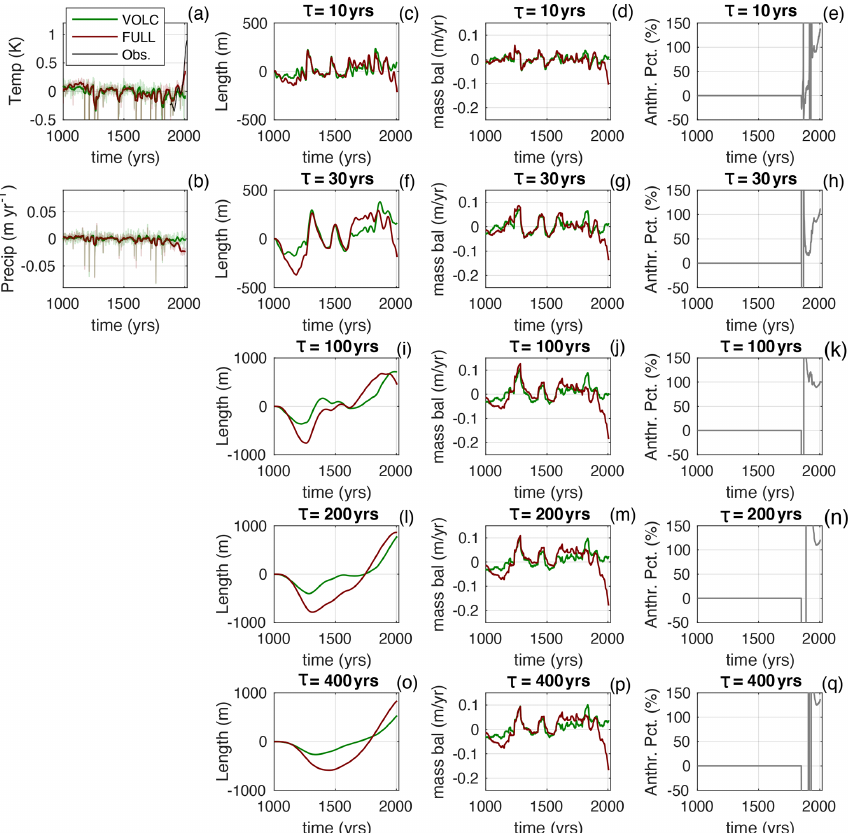
Figure 7. As for Fig. 2 but from CESM millennium ensemble. (a) Northern Hemisphere warm-season (April to September) temperature for the VOLC and FULL ensemble means and compared to observations from GISTEMP v4 starting in 1880; (b) Northern Hemisphere cold-season (October to March) precipitation. Note the small variability and trend in the precipitation. The thicker lines in (a) and (b) are the 20-year running mean. Others columns are the same as for Fig. 2, but here F anth is only calculated after